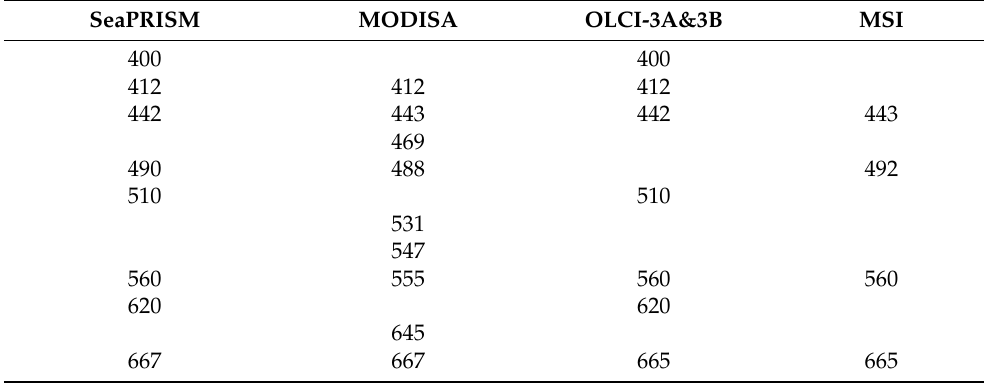
Table 2. Nominal wavelengths (nm) of SeaPRISM, MODISA, OLCI-3A&3B, and MSI in the visible